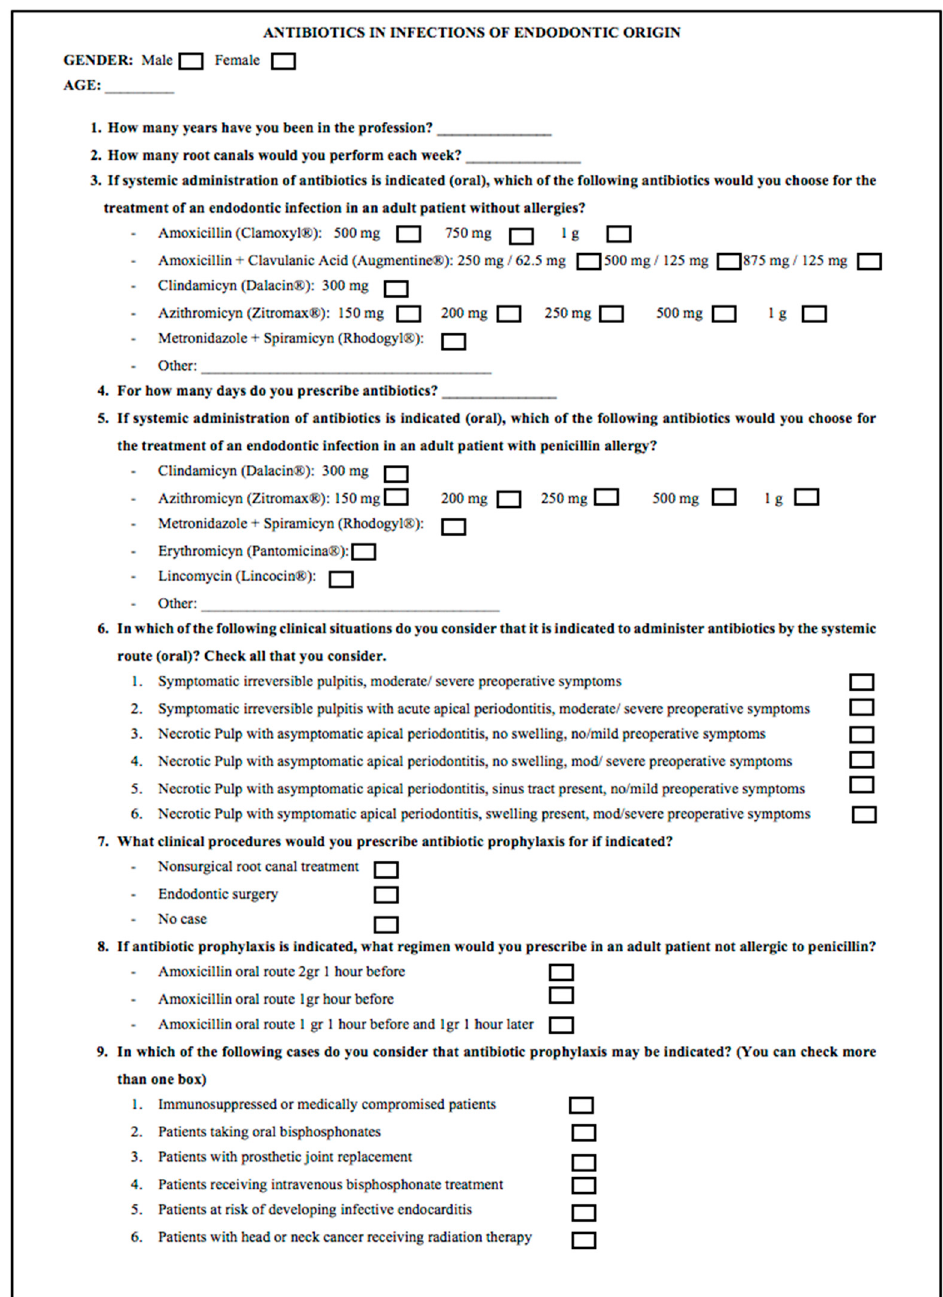
Figure 1. Survey on antibiotic prescribing habits in the treatment of endodontic infections.